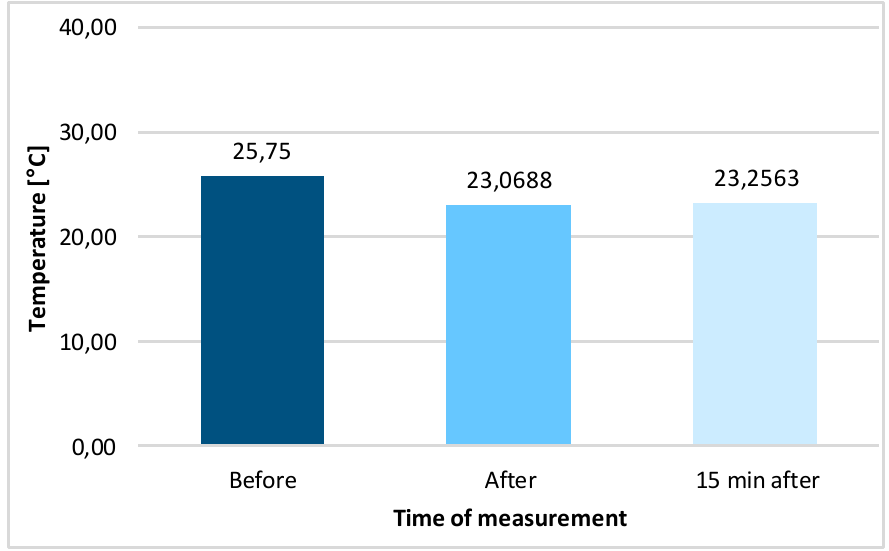
Figure 2 . Average external temperature values measured on the anterior side of the left lower leg before, after and 15 minutes after winter swimming.